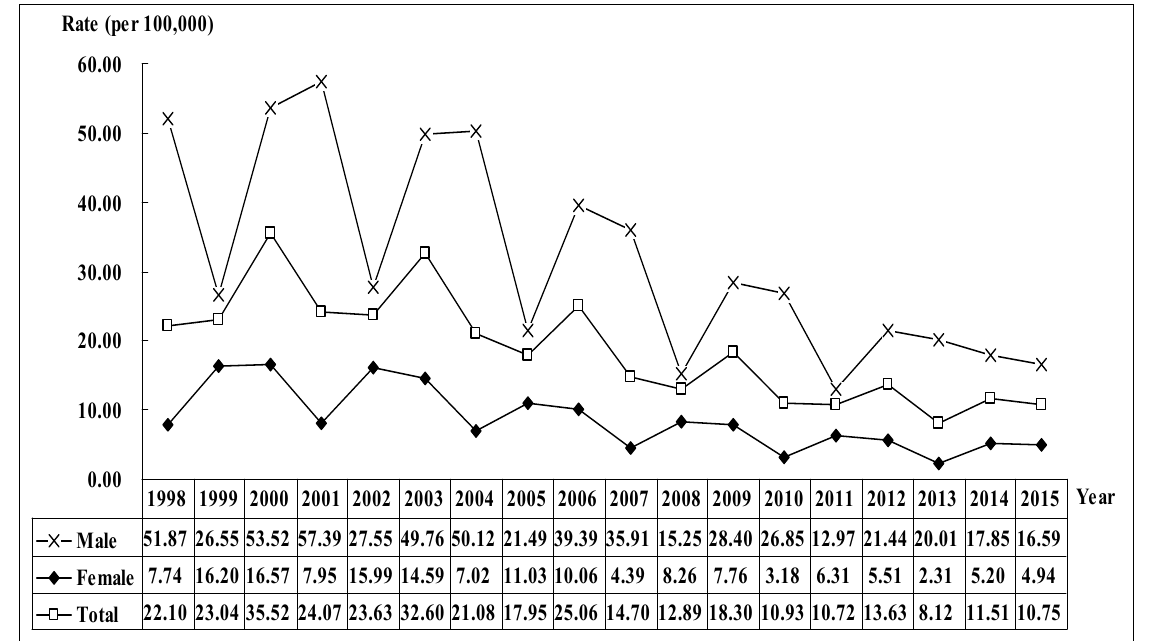
Figure 1. The trend of homicide hospitalization rates by gender in Taiwan, 1998–2015. The age group of 15–24 years had the highest hospitalization rate (per 100,000) among all age groups, followed by the 25–44-year group. However, except for the children aged 0–4 years, the hospitalization rates in the other age groups all showed a decreasing trend (Figure 2).